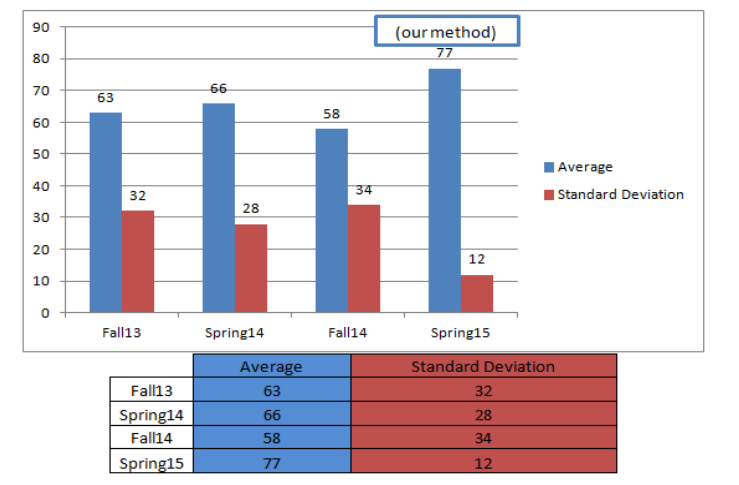
Fig. 15. Performance result